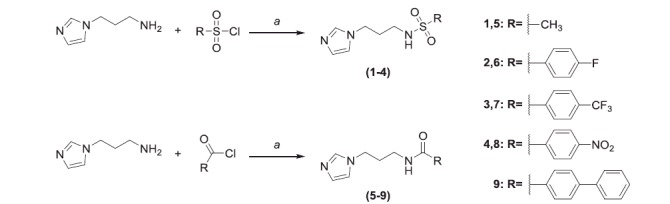
General synthesis of 1–9. Reagents and conditions: (a): TEA, dry CH2Cl2, 12–48 h, RT.